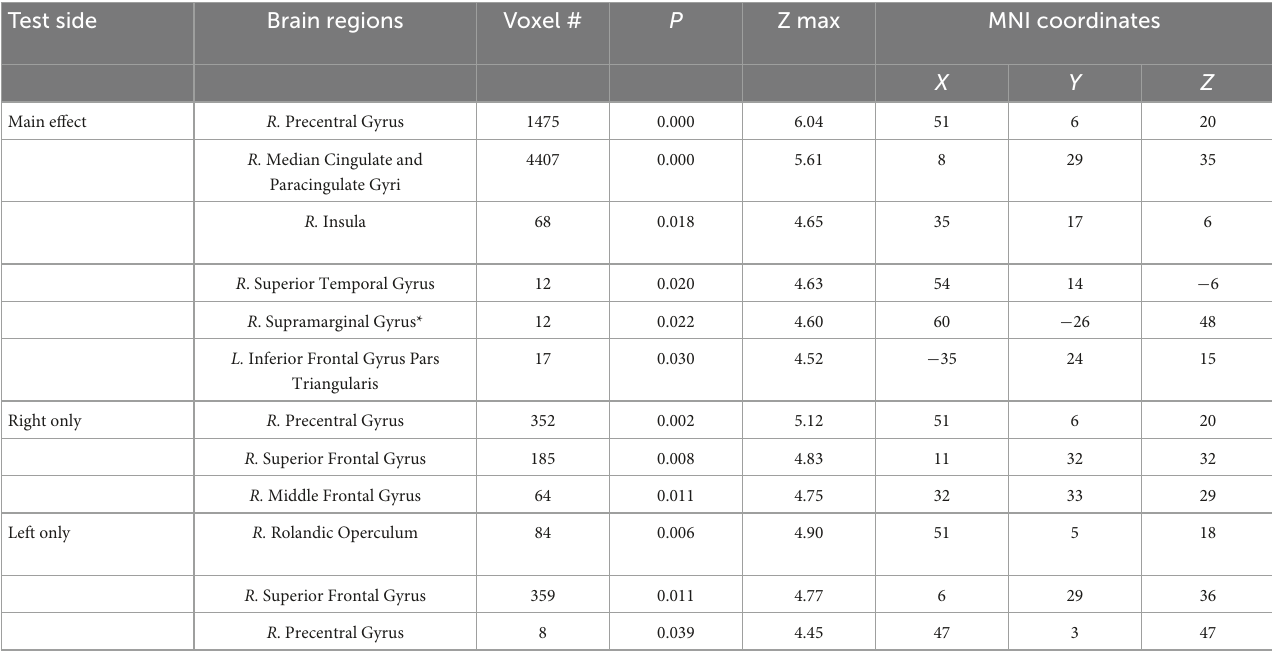
*BOLD signal percentage change was significantly correlated with JPS mean absolute error for the left leg. BOLD, blood oxygen level dependent; JPS , joint position sense condition; Flex , leg flexion without JPS task condition; Rest , rest condition; Test side: the leg that was active during the JPS test; Voxel #: indicates number of activated voxels in this cluster; P : 0.05 family wise error rate corrected (cluster level); Z max: Z-score of the voxel with the highest activity for main effect from condition; MNI: (Montreal Neurological Institute) voxel with the highest activity in MNI-space. R. ,right; L .,left.